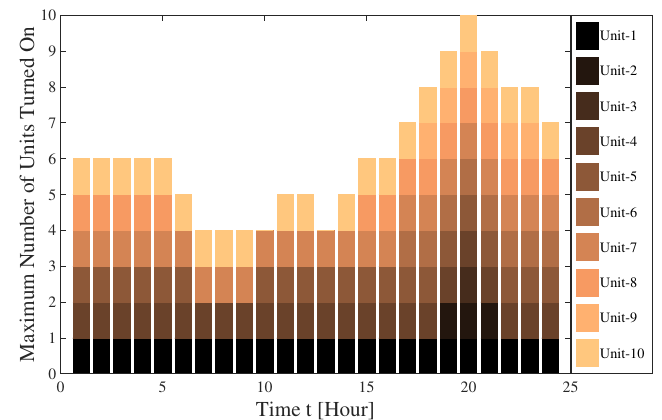
Figure 2. Number of thermal generation (TG) units turned on without considering ESS.